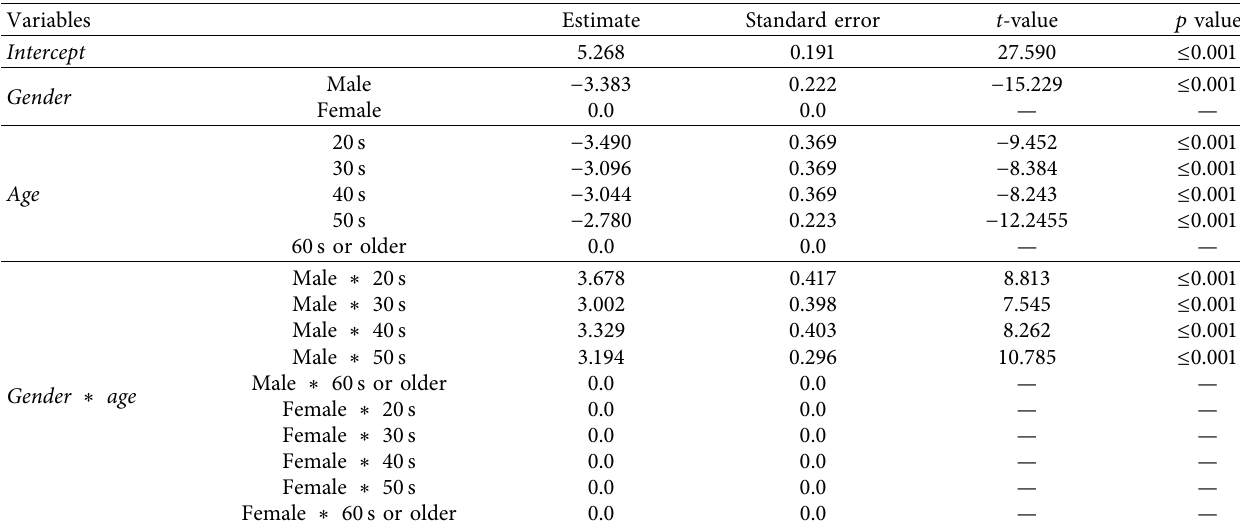
Table 14: Estimated takeover time from LMM by gender and age.